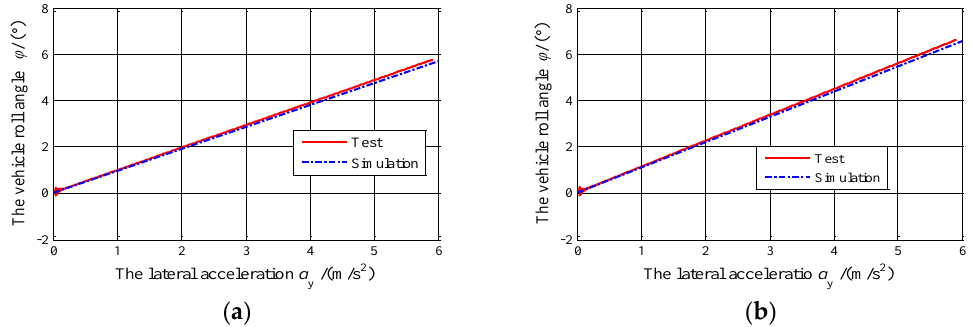
Figure 8. A comparison of the curves of the body roll angle versus the lateral acceleration for the truck with: ( a ) the multi-leaf spring, and ( b ) the taper-leaf spring.